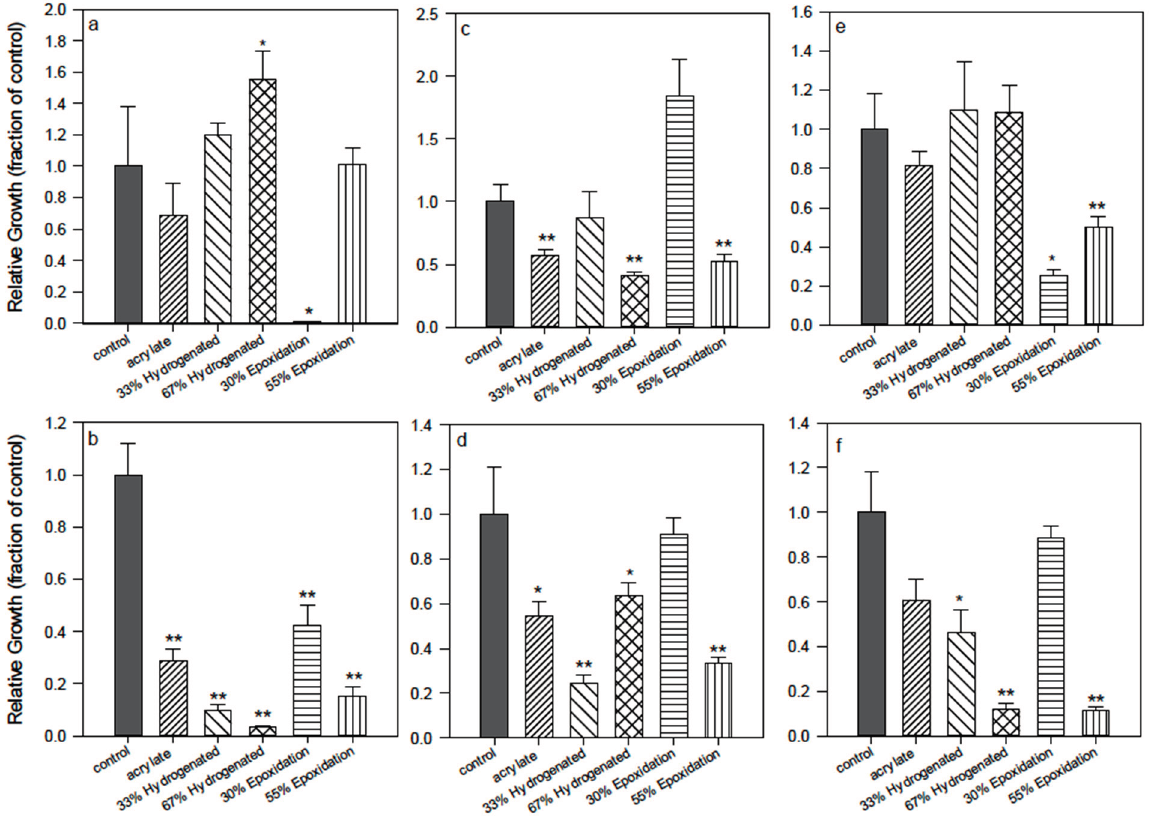
Figure 3. Effect of hydrogenation or epoxidation of acrylate (1) . 33%–67% hydrogenation = oligomer (3) ; 30%–55% epoxidation = oligomer (2) . Pseudomonas aeruginosa ( left ), Staphylococcus aureus ( middle ), Staphylococcus epidermidis ( right ). ( a ), ( c ), ( e ) = bacteria suspended in the supernatant media; ( b ), ( d ), ( f ) = bacteria attached to the control (polystyrene) or polymer surface. * , difference in values significant at p ≤ 0.05, ** difference in values significant at p ≤